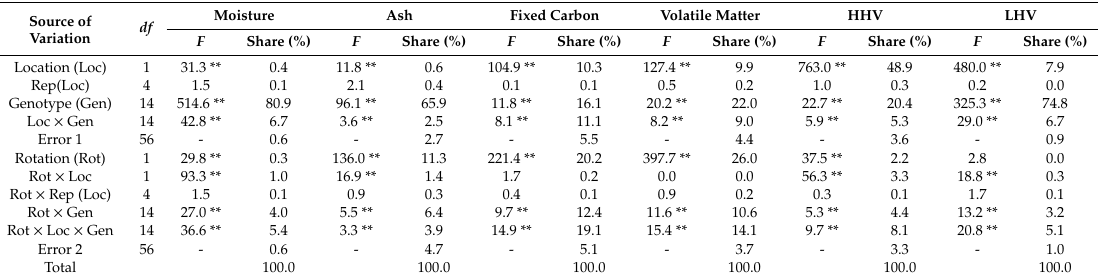
Table 1. Statistics F from the repeated measure variation analysis and the percentage share of e ff ects in the total variation for the thermophysical characteristics of willow biomass. Moisture Ash Sourceof df Variation